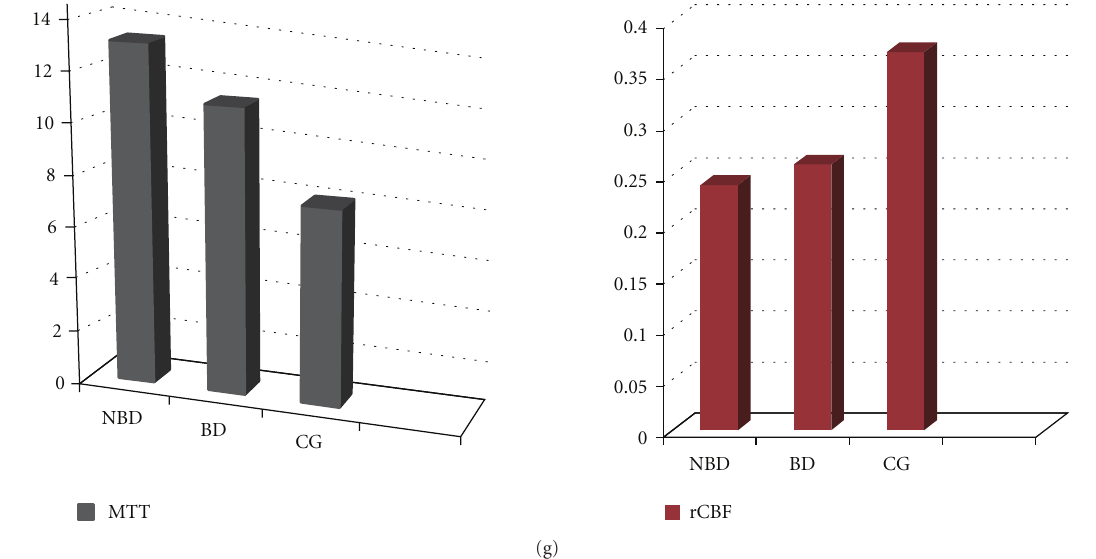
Figure 2: The comparative mean values of MTT and rCBF parameters between each of three groups in (a) pons (NBD: neuro-Behcet’s disease ( n : 12)), (BD: Behcet’s disease ( n :22)), (CG: control group ( n :16)), (b) cerebral peduncle, (c) corpus striatum, (d) temporal lobe white matter, (e) posterior limb of internal capsule, (f) periventricular white matter, (g) parietal cortex.